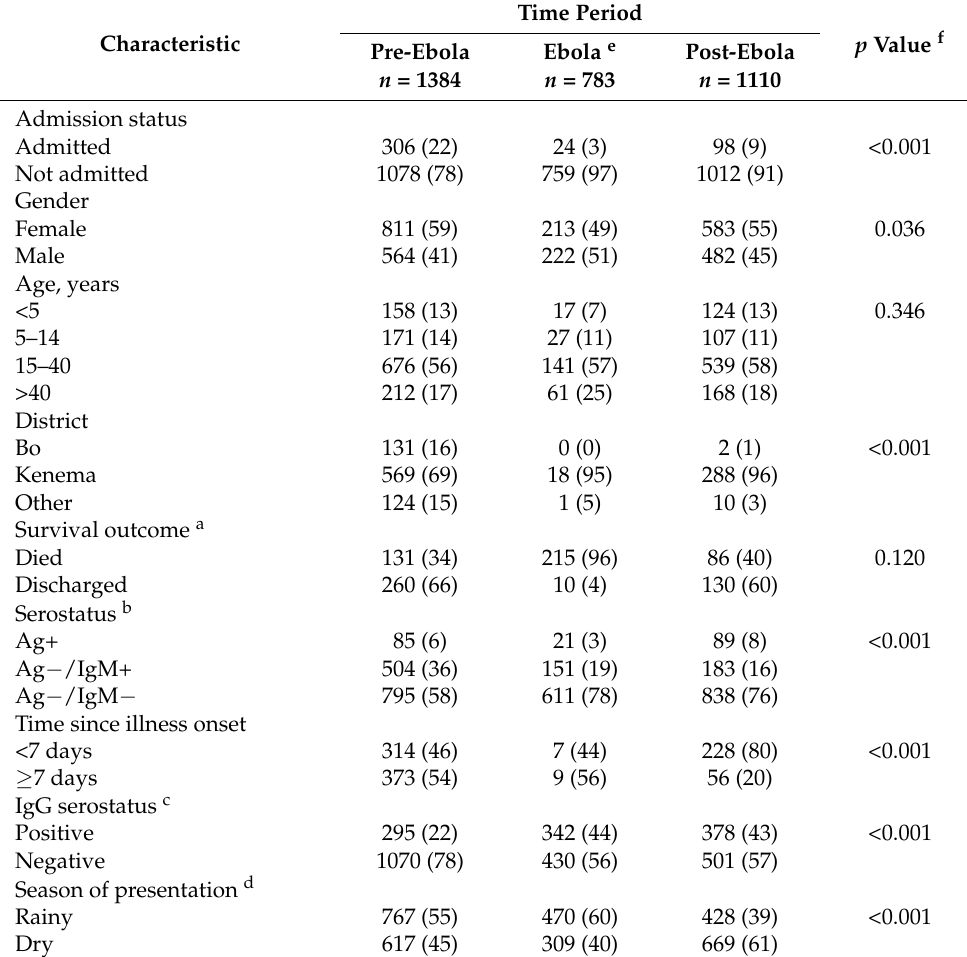
Table 3. Characteristics of suspected Lassa fever cases before, during, and after the 2014–2016 Ebola epidemic, Kenema Government Hospital, 2012–2019. Note. All results expressed as frequencies and percentages unless indicated otherwise. Those characteristics with aggregate frequencies less than their respective aggregate serostatus group sample sizes reflect missing characteristic responses. Date classifications for comparisons between the pre- and post-Ebola periods were based on the first and last reported cases at KGH (25 May 2014 and 7 November 2015,